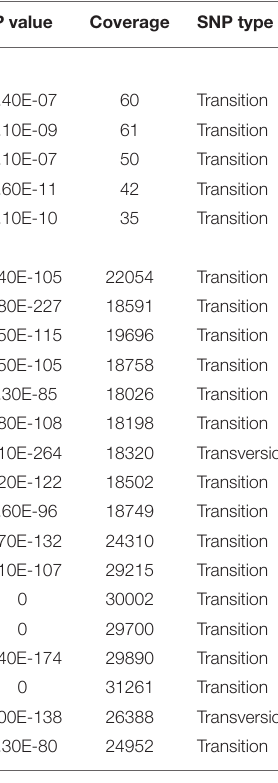
TABLE 3 | Single nucleotide variations (SNVs) called from the RNA and DNA Illumina